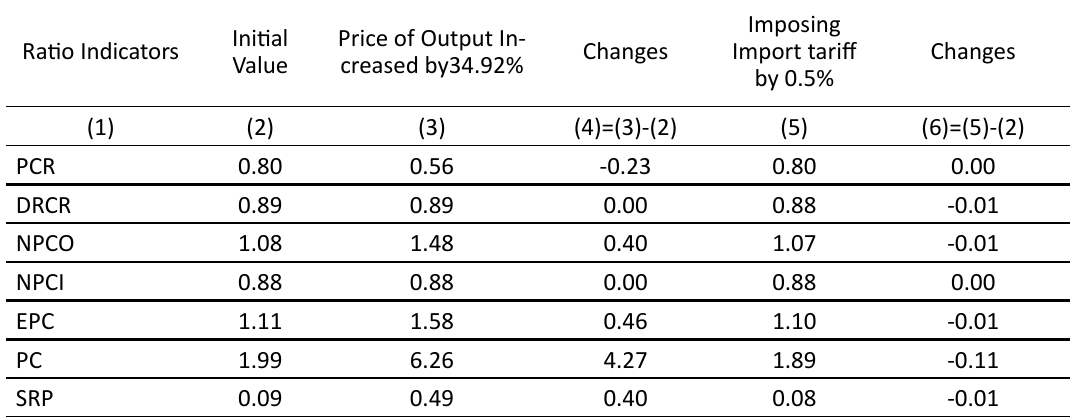
Table 4: Impact of Changes in Output Price Policy and Import